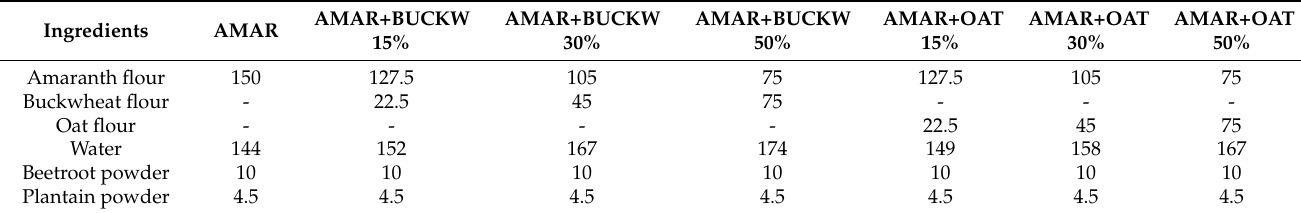
Table 2. Recipes of pasta dough and abbreviations of samples,